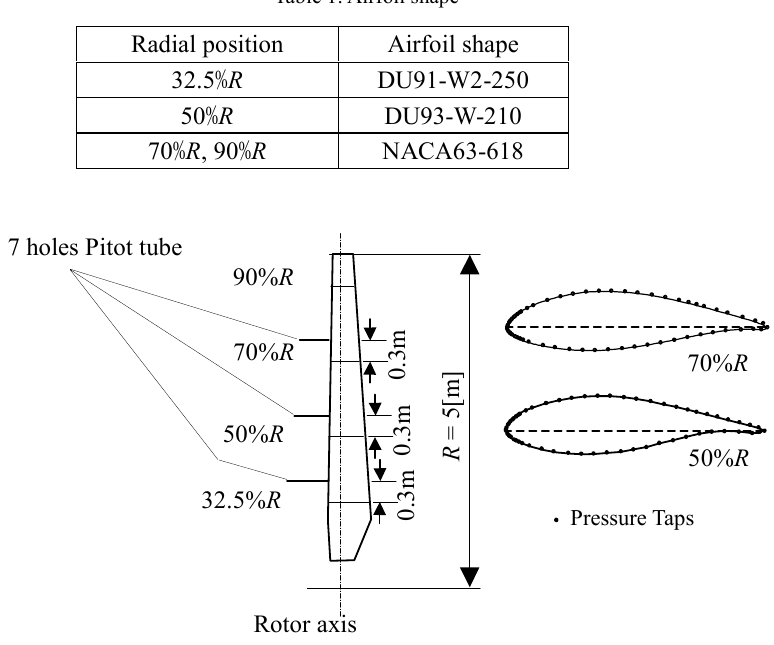
Figure 2. Test blade